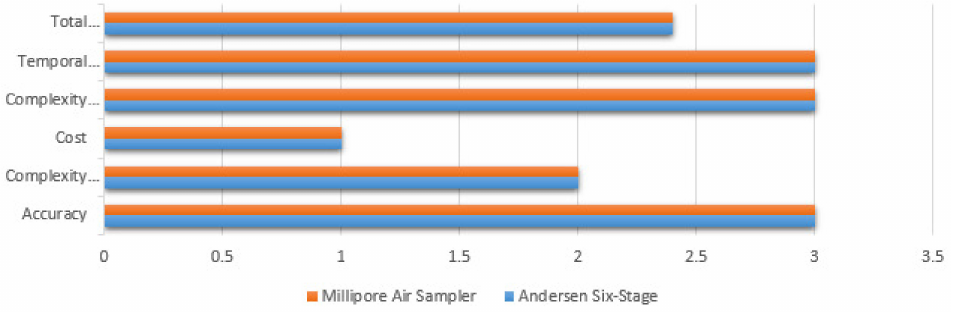
Figure 3. Average scores between active sampling